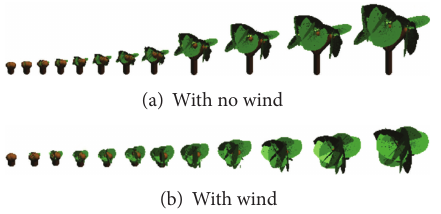
Figure 11: Growth for two seconds with and without wind.